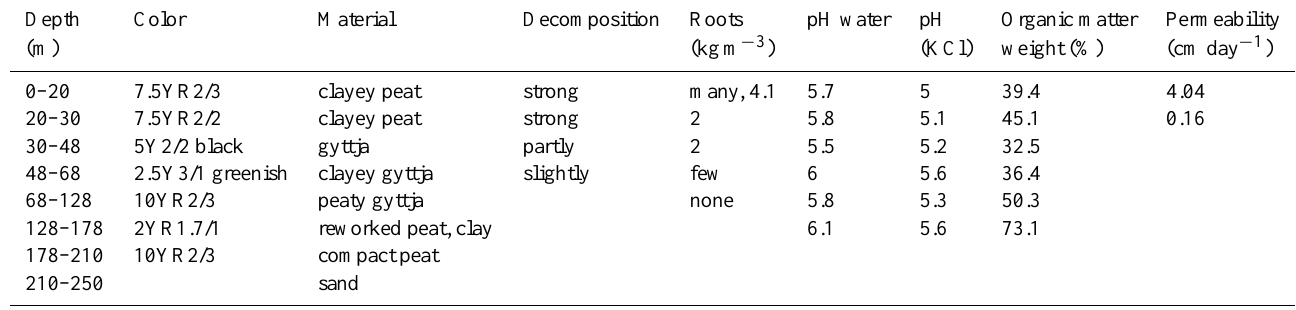
Table 1. Description of a soil profile at the measurement site.